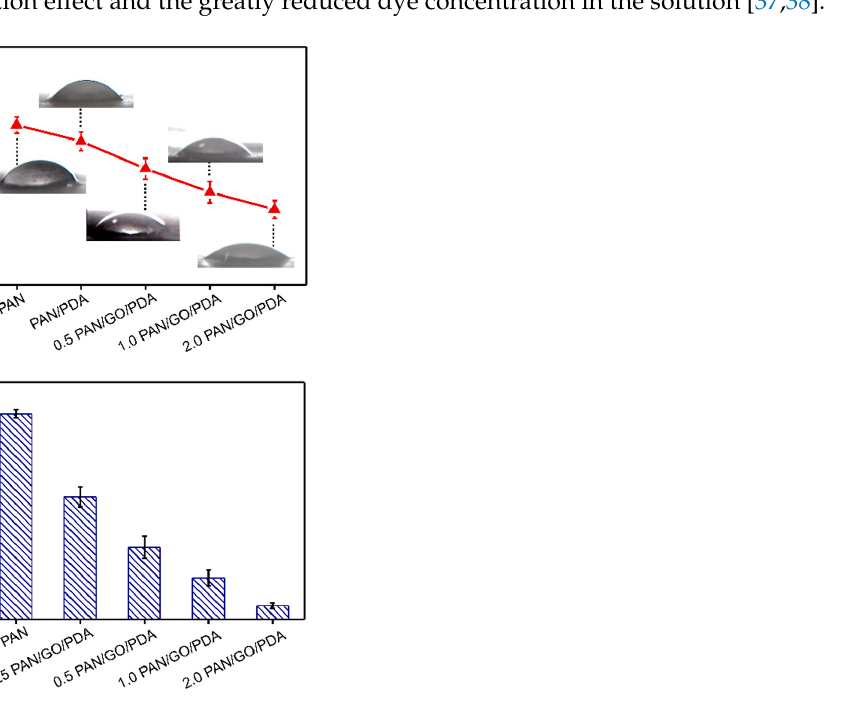
Figure 4. ( a ) Water contact angles of PAN, PAN/PDA, 0.5 PAN/GO/PDA, 1.0 PAN/GO/PDA, and 2.0 PAN/GO/PDA. ( b ) Pure water fluxes of PAN/PDA, 0.25 PAN/GO/PDA, 0.5 PAN/GO/PDA, 1.0 PAN/GO/PDA, and 2.0